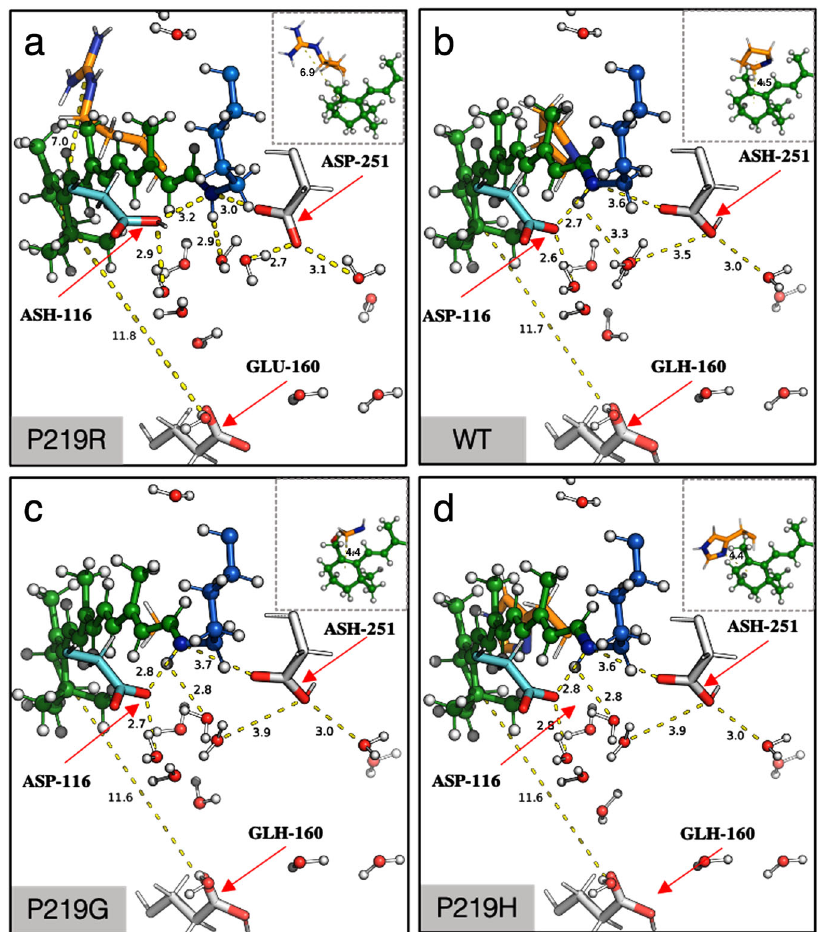
Fig. 9 a -ARM QM/MM-optimized models for P219R, WT-KR2, P219G and P219H. Differences between Hydrogen Bond Network (HBN) presented for ( a ) the only blue-shifted variant (P219R), ( b ) the wild-type (WT-KR2), ( c ) the least red-shifted variant (P219G) and ( d ) the most red-shifted variant (P219H). Hydrogen bonds are represented as dashed lines. The red arrows indicate the protonation state of the relevant